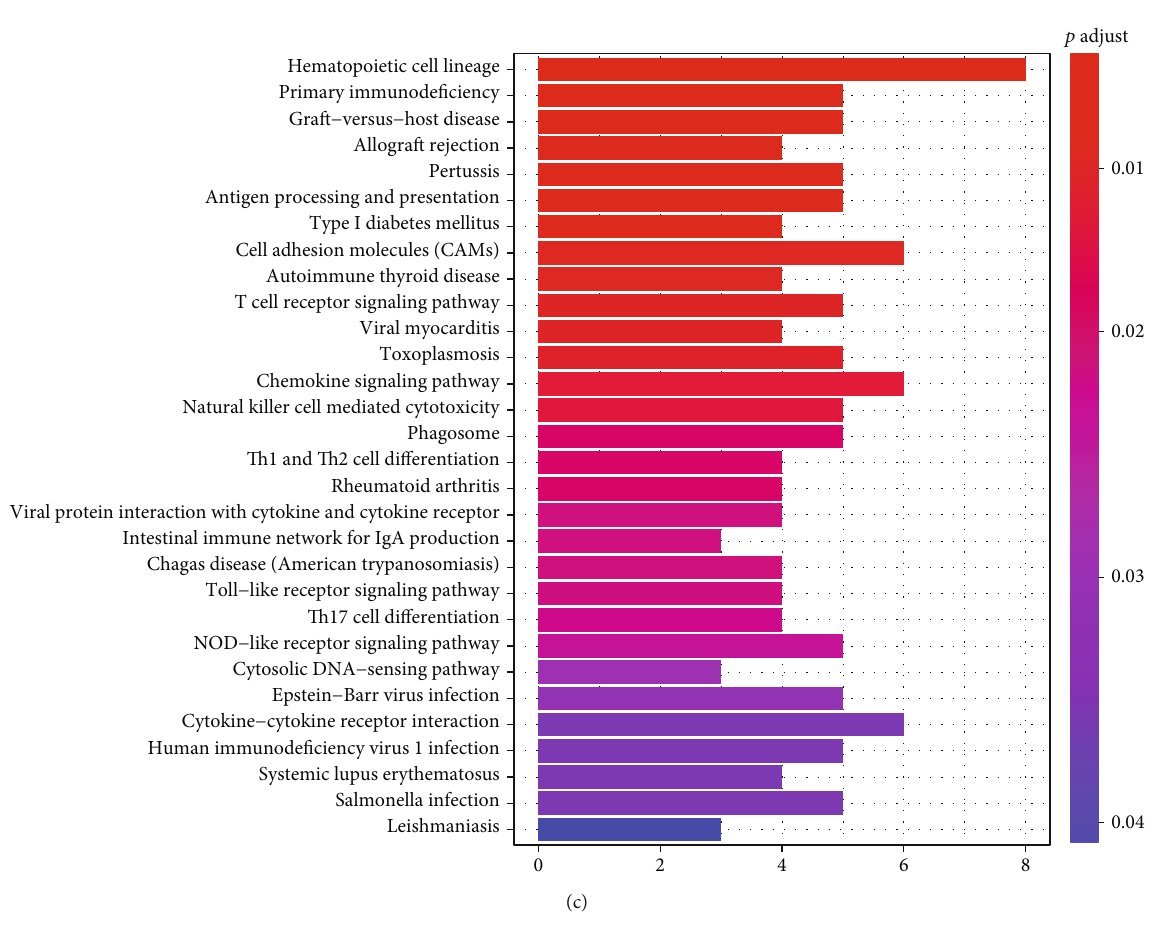
set. Risk score = ð − 1 : 9663 Þ ∗ Exp ð